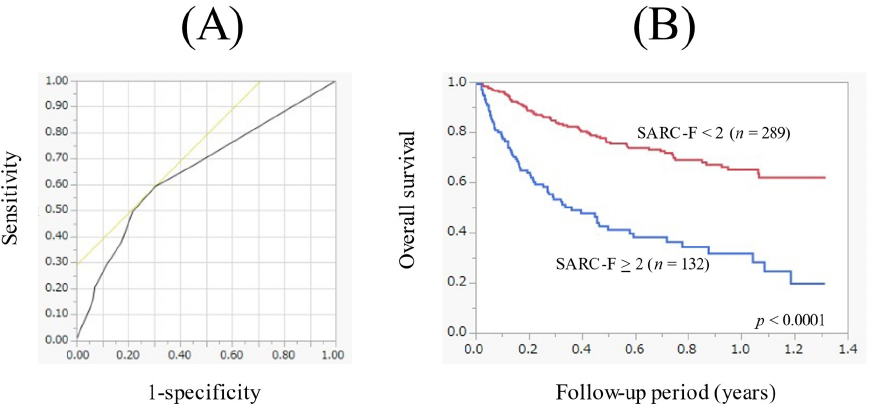
Figure 4. ( A ) Receiver operating characteristics curve based on the prognosis for the SARC-F score. Area under the ROC was 0.66. The sensitivity was 0.59, the specificity was 0.70 and optimal cutoff point of the SARC-F score was 2. ( B ) Kaplan-Meier curves in patients with a SARC-F score ≥ 2 ( n = 132) and <2 ( n = 289).